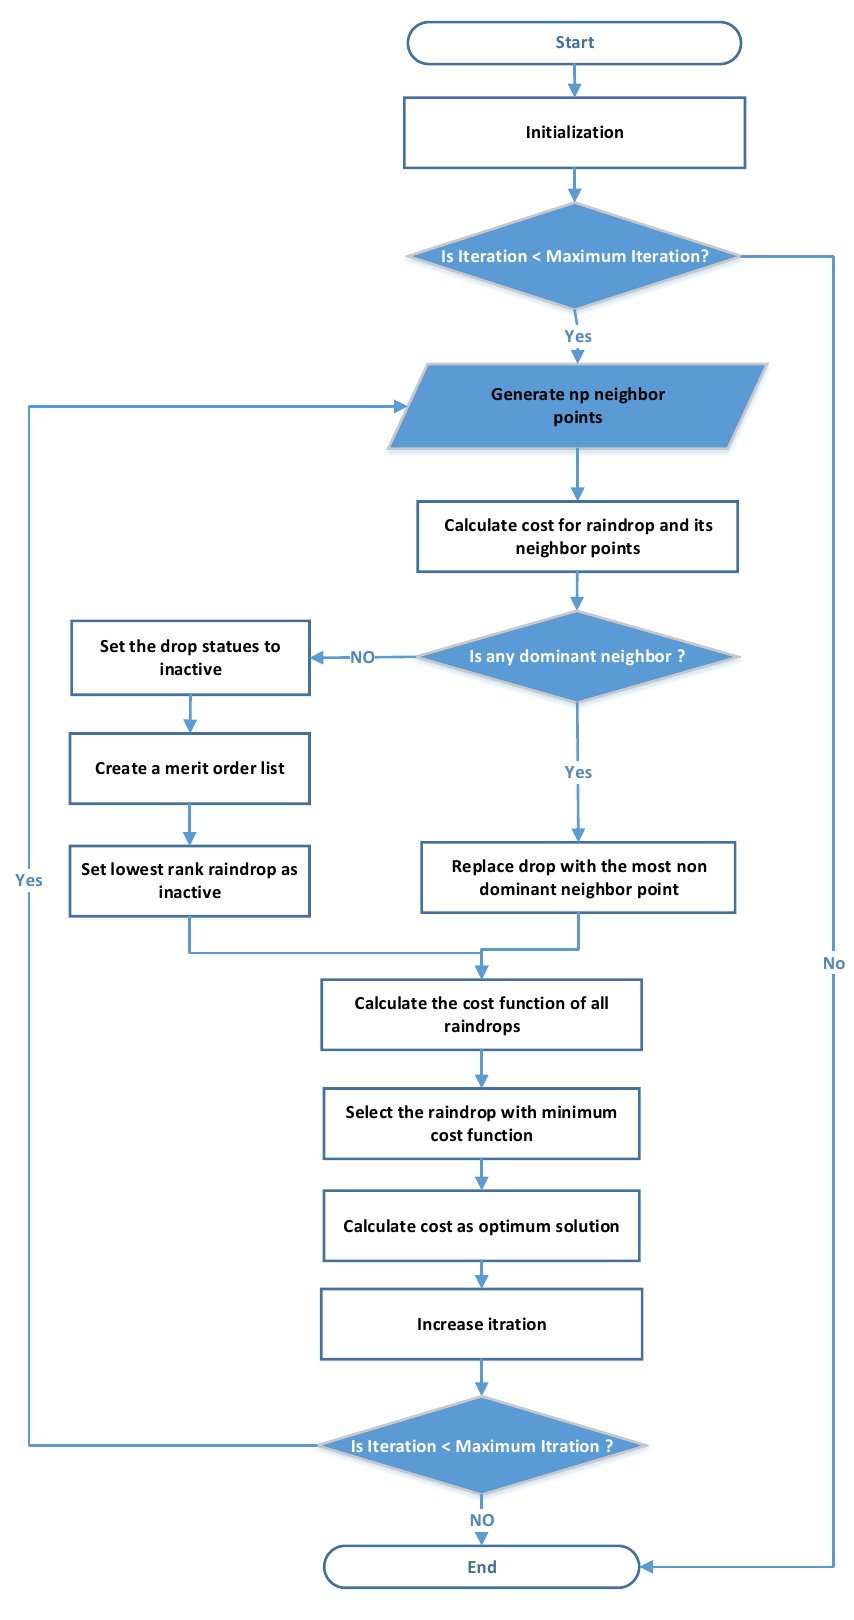
Figure 6. Rainfall optimization algorithm.